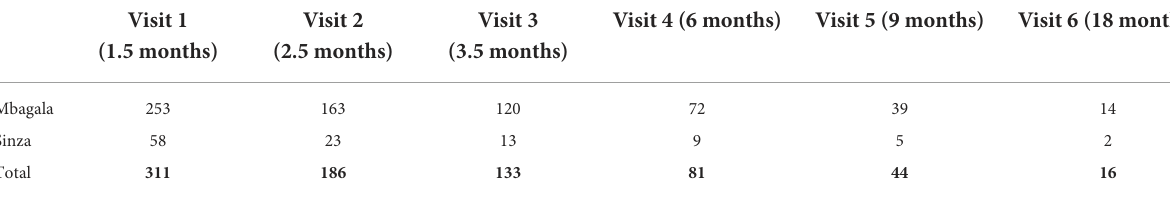
TABLE 2 The number of babies who have attended follow up visits at Mbagala and